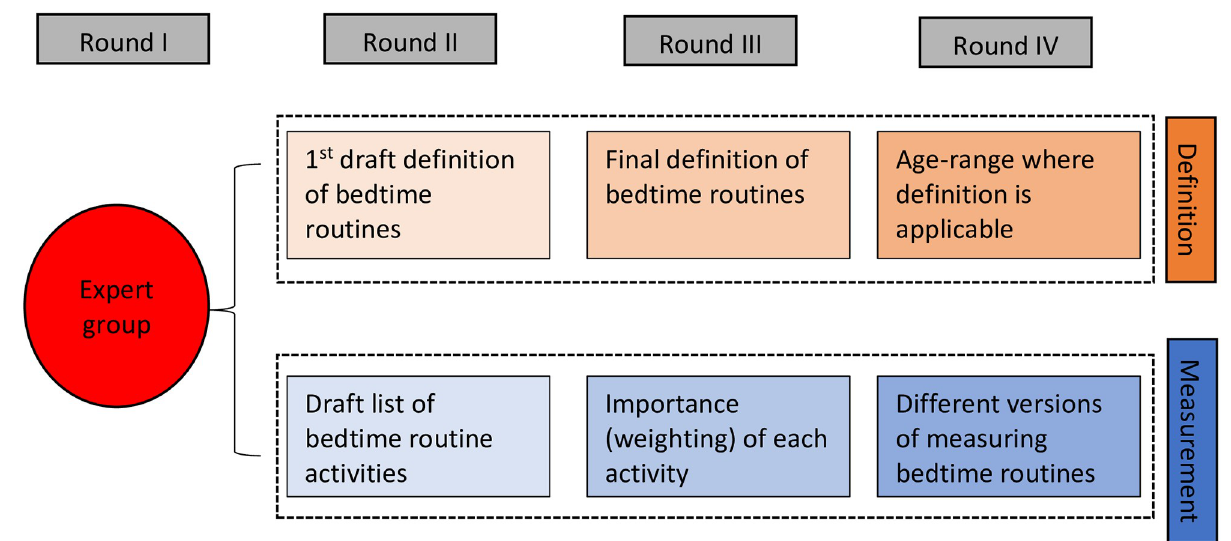
Fig 1. DELPHI process. Overview of DELPHI process